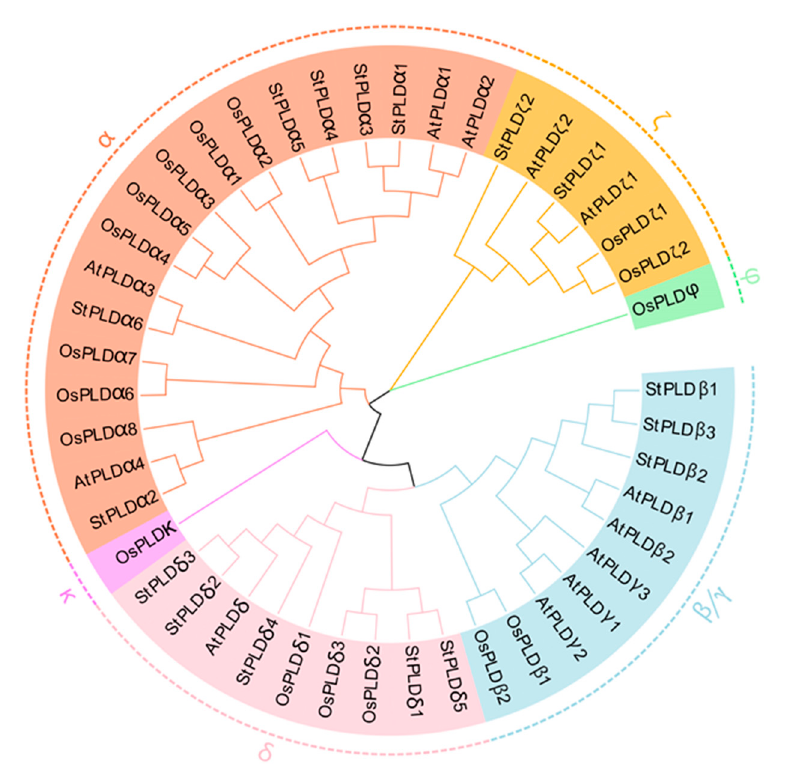
Figure 1. Phylogenetic analyses of the plant PLD proteins. The conserved PLD proteins from potato, rice, Arabidopsis were aligned using ClustalW2.0, and the phylogenic tree was constructed using the NJ method with bootstrapping analysis (1000 replicates).